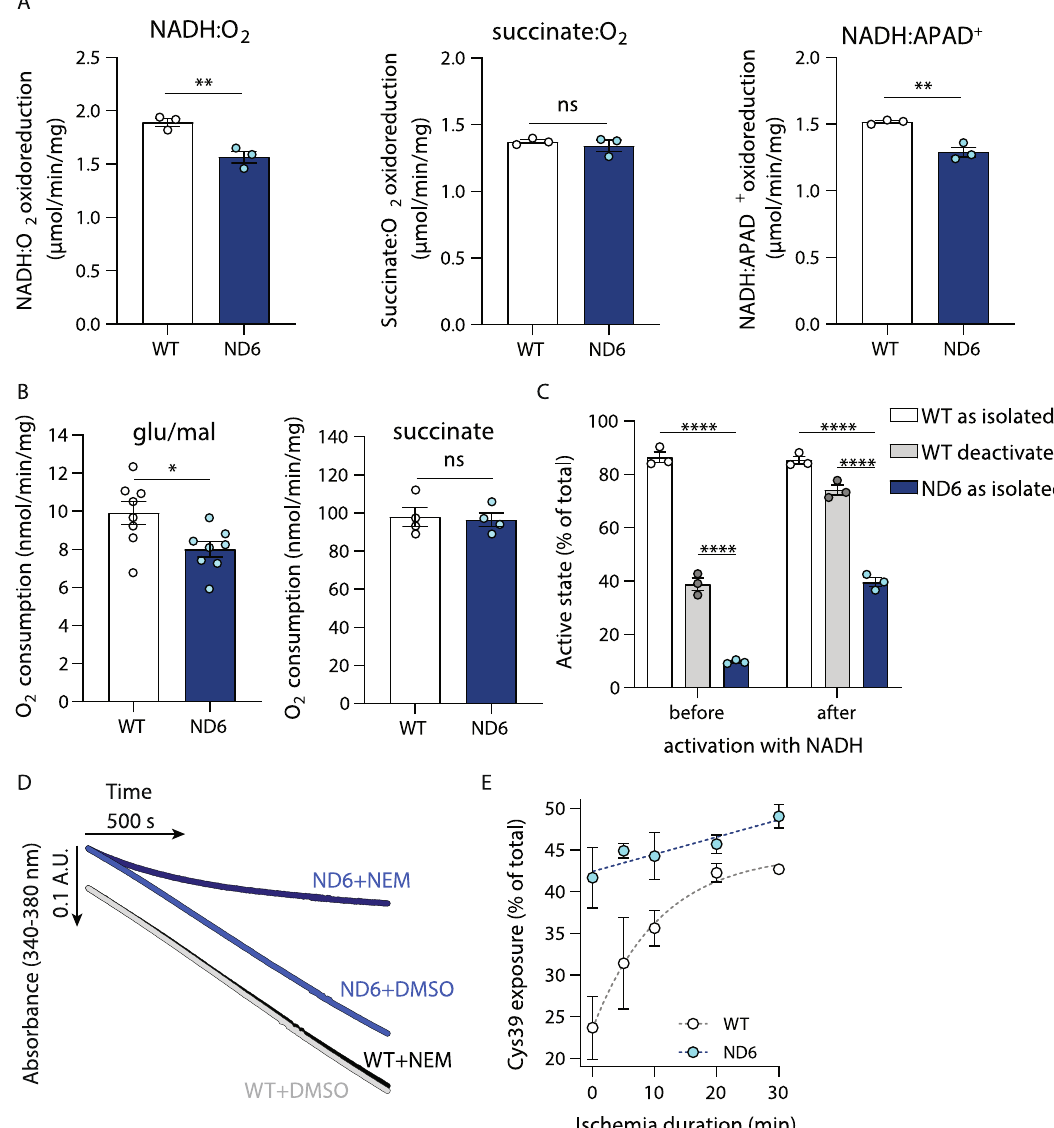
Fig. 2 The active/deactive status and catalytic activity of ND6-P25L and WT complex I. A The rates of NADH and succinate oxidation by complexes I – III – IV and II – III – IV, respectively, in mitochondrial membranes from WT and ND6-P25L (referred to as ND6) mouse heart tissue, and the rate of the complex I-speci fi c NADH:APAD + oxidoreduction reaction. The data are mean averages ± S.E.M. ( n = 3, from three independent preparations each comprising four or fi ve hearts) evaluated using an unpaired, two-tailed Student ’ s t -test (** p < 0.01; p values are 0.0083, 0.5347, 0.0036, respectively). The decreased rate of NADH oxidation in ND6-P25L (83% of WT) is due to the lower amount of complex I present (85% of WT in the NADH:APAD + assay). B The rates of O 2 consumption by isolated heart mitochondria during respiration on glutamate/malate (0.5 mM) and upon subsequent addition of succinate (10 mM). Mitochondria were isolated from four hearts and pooled to provide a single test sample. The data are mean averages ± S.E.M. (glu/mal (glutamate/malate), n = 8, succinate, n = 4, technical replicates) evaluated using an unpaired, two-tailed Student ’ s t -test (* p < 0.05; p values are 0.02 (glu/mal), 0.83 (succinate)). C The percentage of complex I in A-like states in ND6-P25L and WT membranes, either as-isolated or deactivated by incubation for 30 min at 37 °C in the absence of substrates, and before or after activation by addition of 1 mM NADH at room temperature for 10 s. The rates of NADH oxidation by samples treated with NEM were compared to the rates from NEM-free control samples to determine the proportion of A-like complex I present. The data are mean averages ± S.E.M. ( n = 3, from three independent preparations each comprising four or fi ve hearts), evaluated using a 2-way ANOVA test with Tukey ’ s multiple comparisons correction (**** p < 0.0001). D Catalytic activity assays of NADH oxidation by mitochondrial membranes from WT and ND6-P25L mouse hearts show linear rates of catalysis. The membranes are fully active prior to addition of 1 mM NEM at the start of the traces shown here. The NEM does not affect catalysis by WT-CI, but rapidly inhibits catalysis by ND6-P25L-CI. E Deactivation of complex I determined by differential labeling of the ND3-Cys39 peptide using light and heavy ( 13 C 2 , 2-d 2 ) labeled iodoacetamide, followed by LC-MS/MS analysis. The data are the percentage of ND3-Cys39 that is exposed to derivatization at the start of tissue homogenization for hearts from WT and ND6-P25L mice, following various times of ischemia. The data are mean averages ± S.E.M. from experiments on three independent